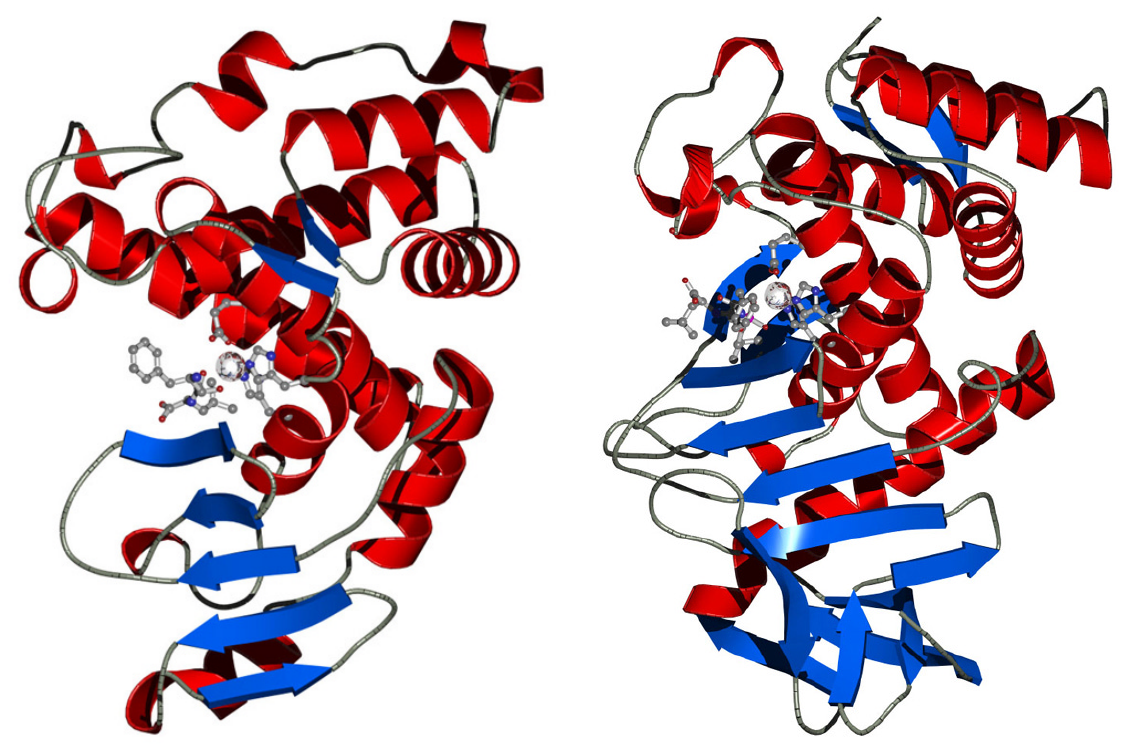
FIGURE 4. Structure of the catalytic domain and a comparison with thermolysin. (A) Ribbon diagram of the catalytic domain; α - helices are in red, β -strands are in blue. The three zinc ligands, His-295, His-299, and Glu-318, and the inhibitor bestatin are depicted in ball-and stick representation The zinc ion is shown as a CPK model. (B) Structure of thermolysin in the same orientation as the catalytic domain; α -helices are in red, β -strands are in blue. The three zinc ligands, His-142, His-146, and Glu-166, as well as the inhibitor Cbz-GlyP-(O)-Leu-Leu50, are depicted in ball-and stick representation. The zinc ion is shown as a CPK model. phenyl group of the inhibitor is bound in an hydrophobic pocket. In the vicinity of the prosthetic zinc, the catalytic residues Glu-296 and Tyr-383 are located at positions that are commensurate with their proposed roles as general base and proton donor in the aminopeptidase